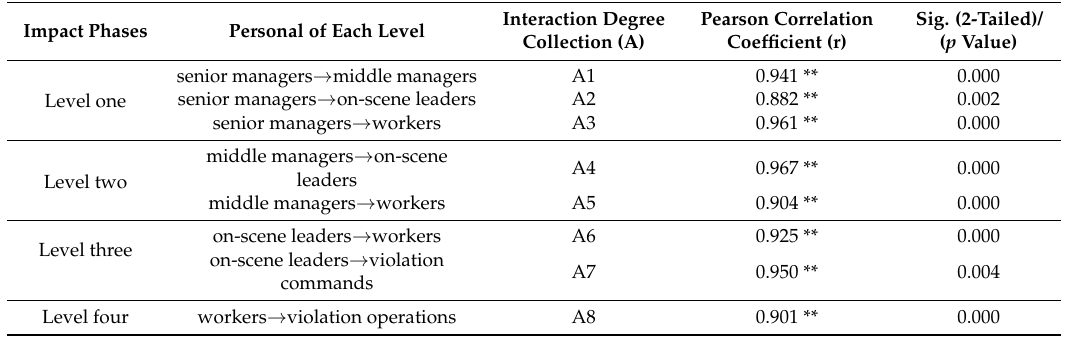
Table 3. The correlation analysis results of unsafe behaviors produced by different functional levels’ personnel in coal